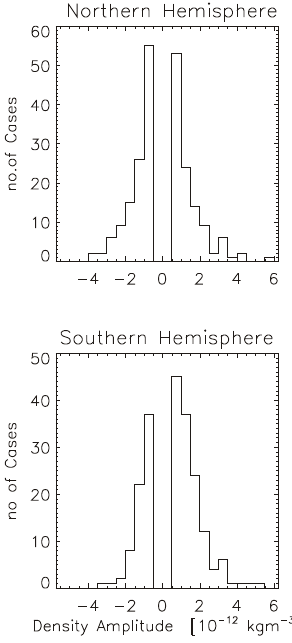
Fig. 2. Distribution of the amplitude of the density maxima (right hand part) and of the minima (left hand part) for the Northern (upper panel) and Southern (lower panel)